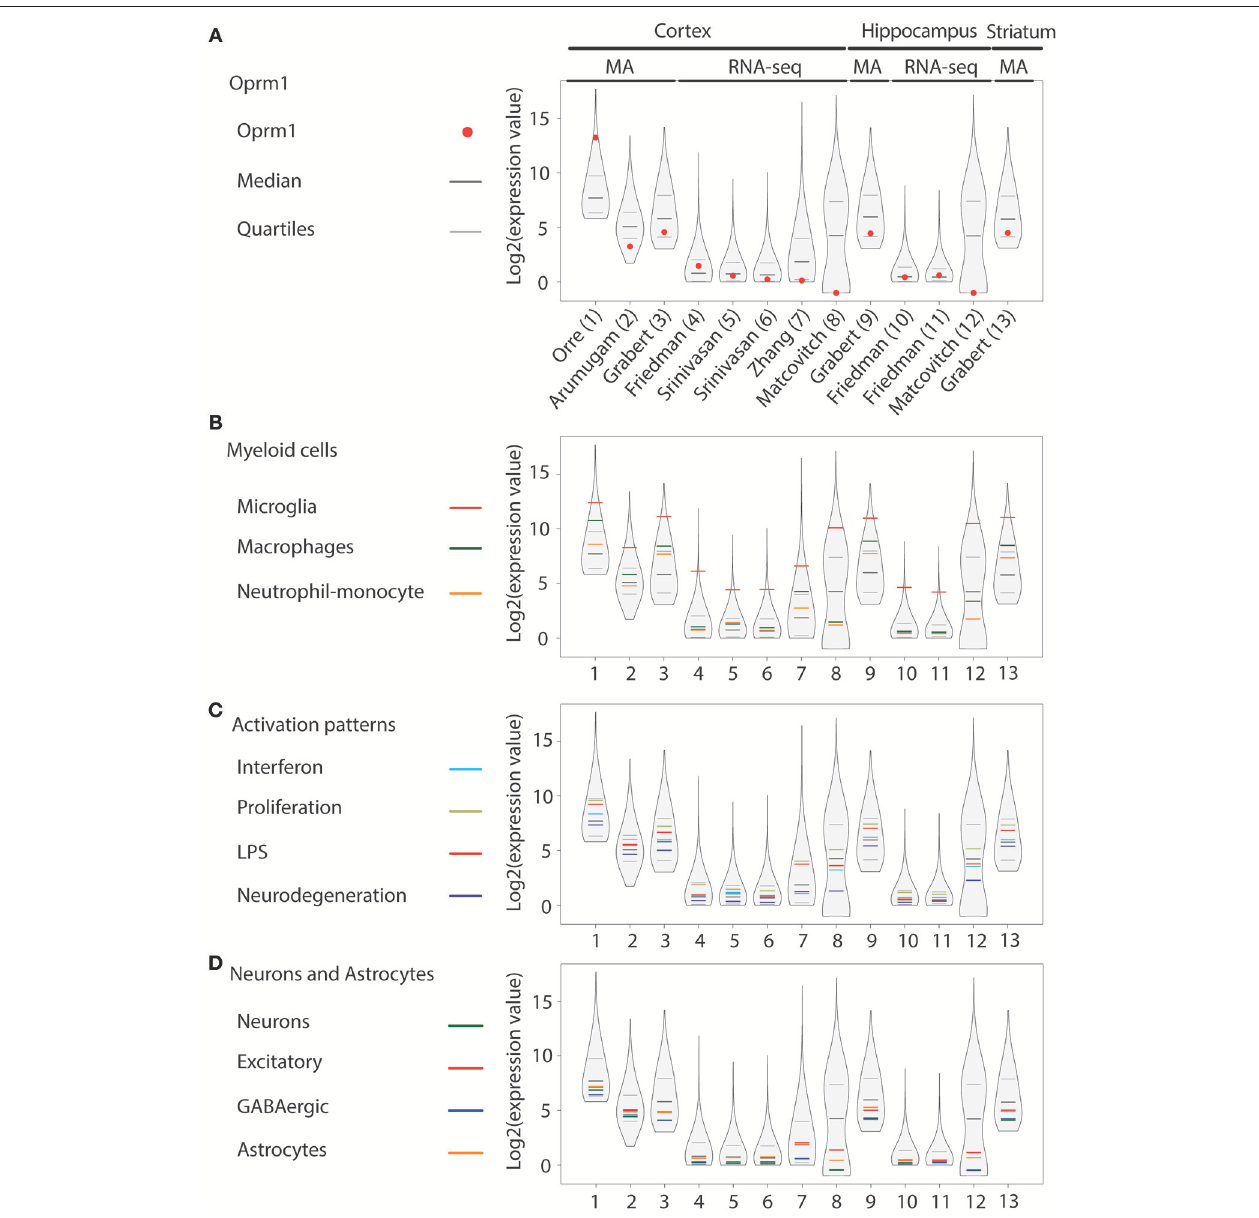
FIGURE 2 | Oprm1 and gene clusters expression in mouse cortex, hippocampus and striatum microglia datasets. Expression levels of the genes identified in each dataset are represented in violin plots demonstrating the median, as well as the 25th and 75th quartiles. Datasets are represented by name of the first author in (A) which are denoted numerically in (B–D) . In mouse cortex and hippocampus, microglia were assayed with either microarrays (MA) or RNA-sequencing (RNA-seq) as underlined on (A) and assayed with MA only in the striatum (dataset #13). (A) Oprm1 expression values were distributed below and above the median independent of the assay used to measure gene expression. RNA-seq datasets (#8 and 12) yielded to no expression of Oprm1 in microglia. The highest Oprm1 expression value was yielded by dataset #1 in cortical microglia. (B) Among the Myeloid gene clusters, the Microglia-related gene module was the mostly highly expressed in all datasets analyzed, with expression values distributed about the 75th quantile. (C) Proliferation-related genes were the most highly expressed within the Activation pattern clusters, distributed within the 75th quantile. (D) Neuron-, GABAergic-, and Astrocyte-related genes had expression values that were below the median in most of the datasets analyzed. In the cortex and hippocampus, the Excitatory neuron- and Astrocyte-related genes are distributed along the median for datasets #5–7 and #10, 11.